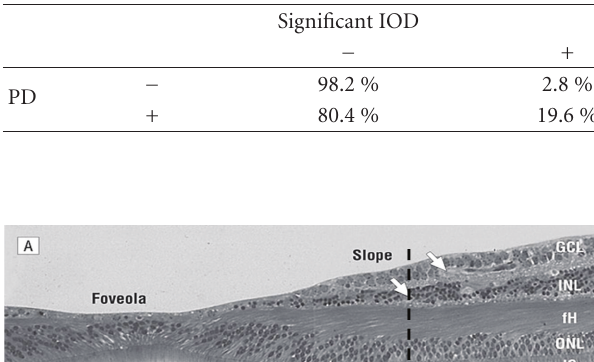
Table 5: Predictive value table for grouped data points at 0.5 and 0.75 mm radial distance (1 SD).